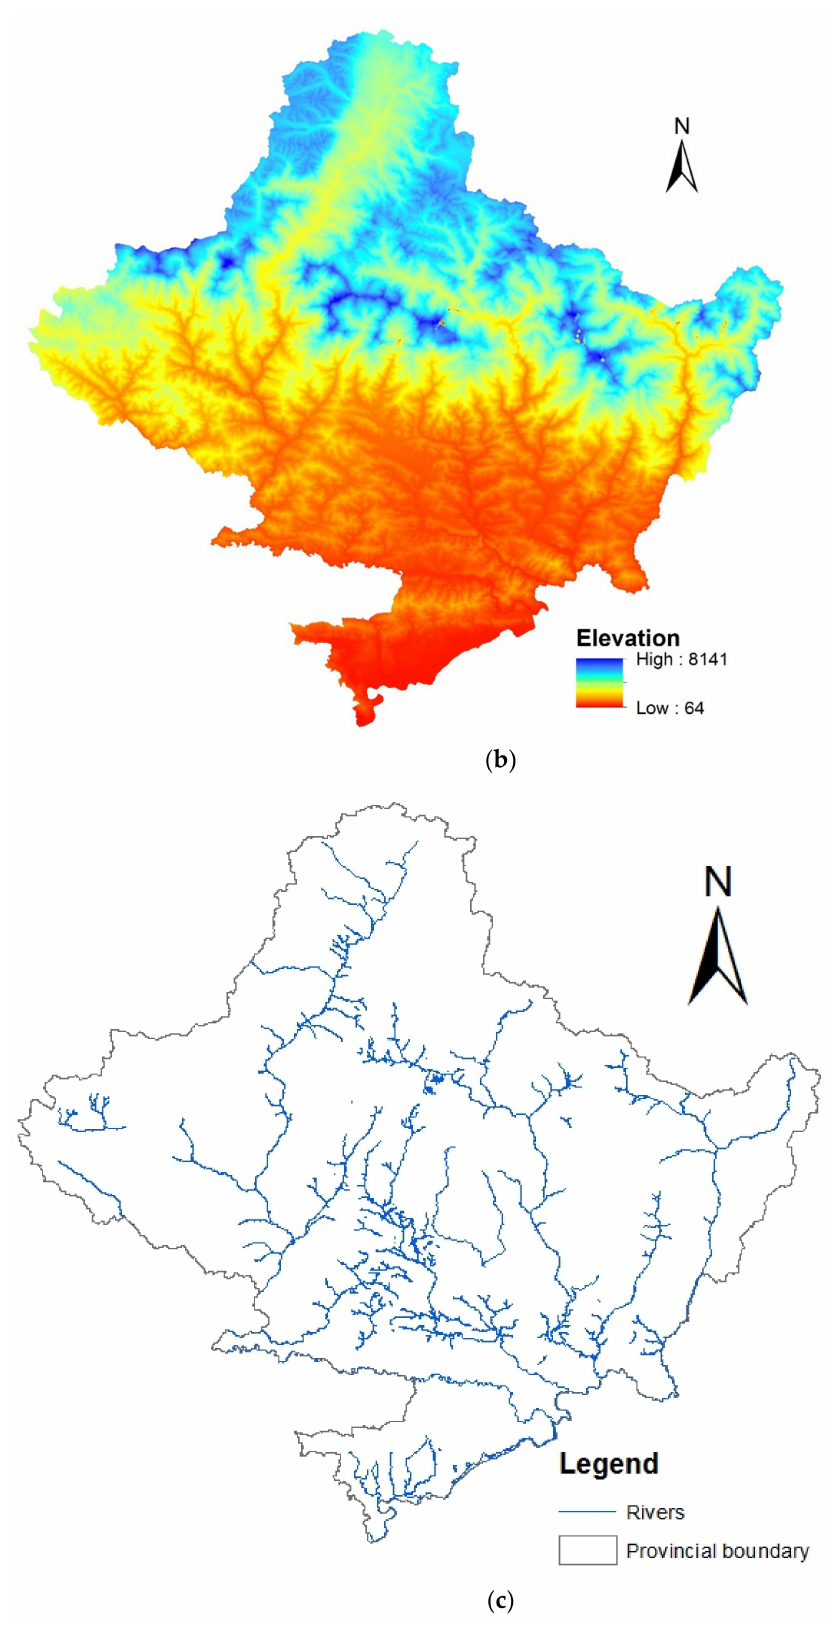
Figure 2. ( a ) Map of Nepal, showing Gandaki Province. ( b ) Elevation variation across Gandaki Province. ( c ) River network inside Gandaki